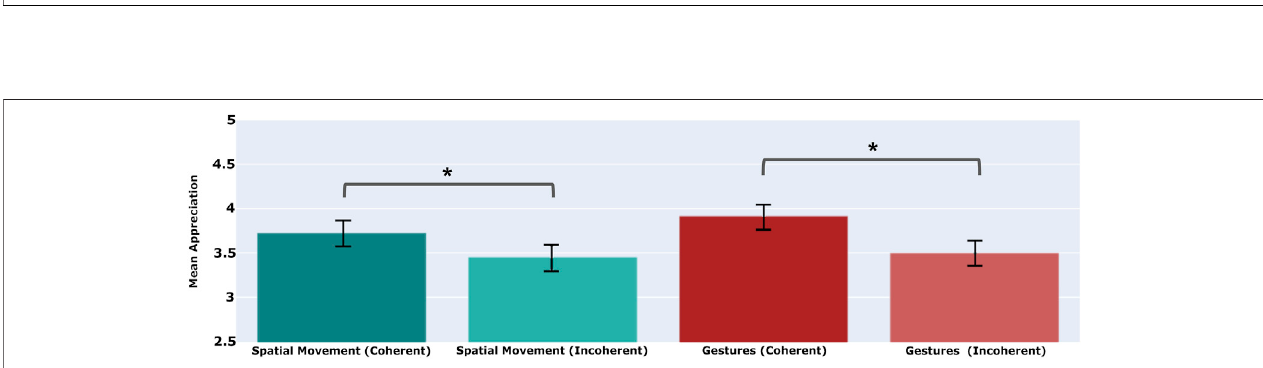
FIGURE 7 | Coherent use of spatial movement in a performance – to and fro movements dictated by a performer ’ s interpretation of the current plot action – are appreciatedmorebyaudiencesthanincoherentmovementsthatarechosenatrandom,orchosencontrarytothatinterpretation.Thesamecanbeseenforcoherentvs. incoherent gestures. A star indicates a signi fi cant difference between the mean values ( p < 0 . 05), while the whiskers show the standard error of the mean.